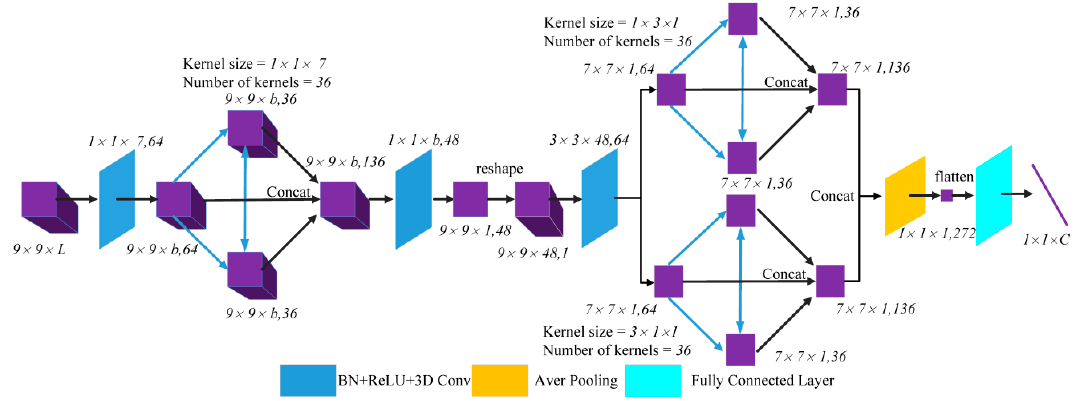
Figure 5. The AUSSC proposed for hyperspectral image (HSI) classification of labeled pixels with an